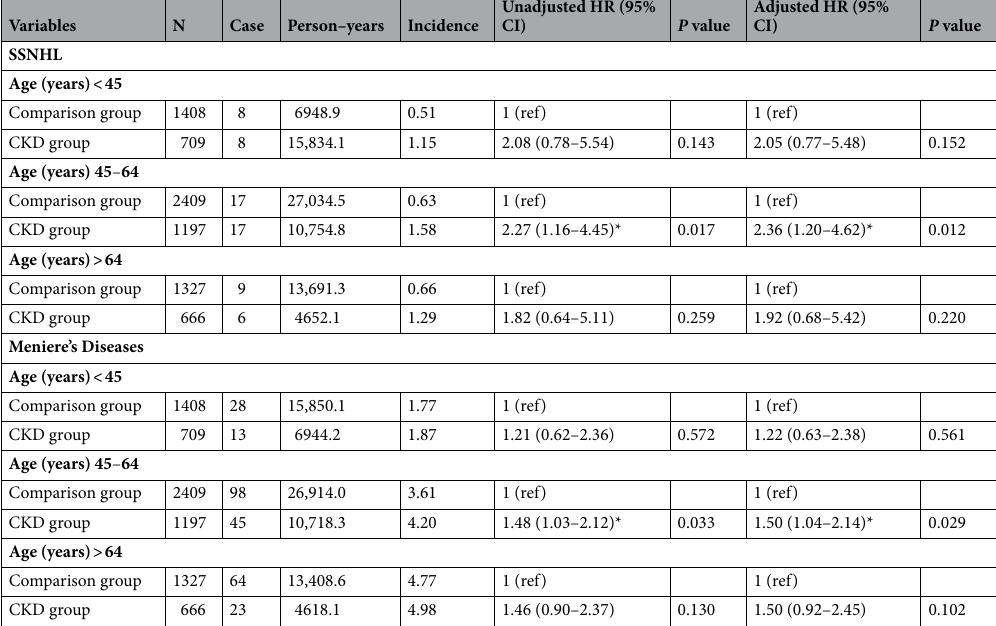
Table 4. Hazard ratios of sudden sensorineural hearing loss or Meniere’s disease by age between patients with and without chronic kidney disease. SSNHL, Sudden sensorineural hearing loss; CKD, Chronic kidney disease; CI, Confidence interval (* P < 0.05).